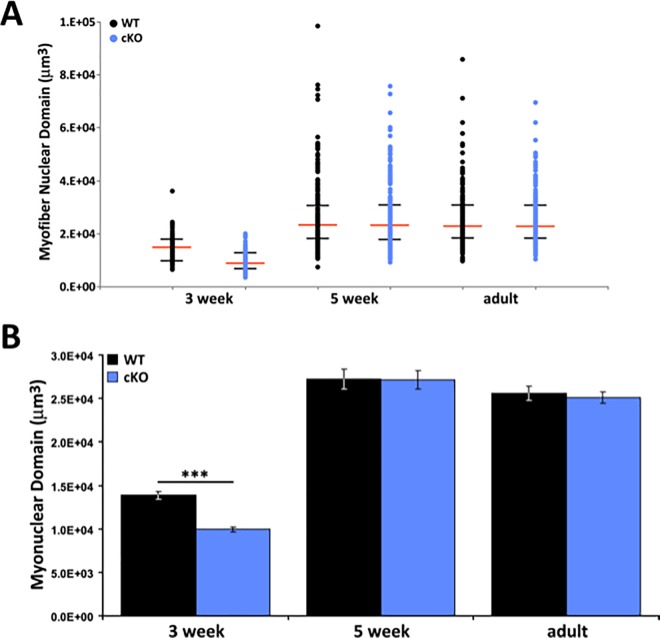
Recovery of myonuclear domain size by 5 weeks of age.(A) Distribution of individual myofibers from the EDL muscle as plotted by myonuclear domain (volume/nuclei) per fiber in Atrx cKO and littermate controls. Median and quartile points are represented for each animal group by a red and black hash marks respectively. (3 week WT, cKO: n = 110, 119 fibers; 5 week WT, cKO: n = 160, 149 fibers; adult WT, cKO: n = 183, 212 fibers). (B) Average myonuclear domain per fiber in EDL muscle in Atrx cKO and littermate controls (mean ± SEM; ***p<0.001 by student’s t-test). Fibers were collected from 2 mice/group at 3 weeks; 3 mice/group at 5 weeks and adult ages.